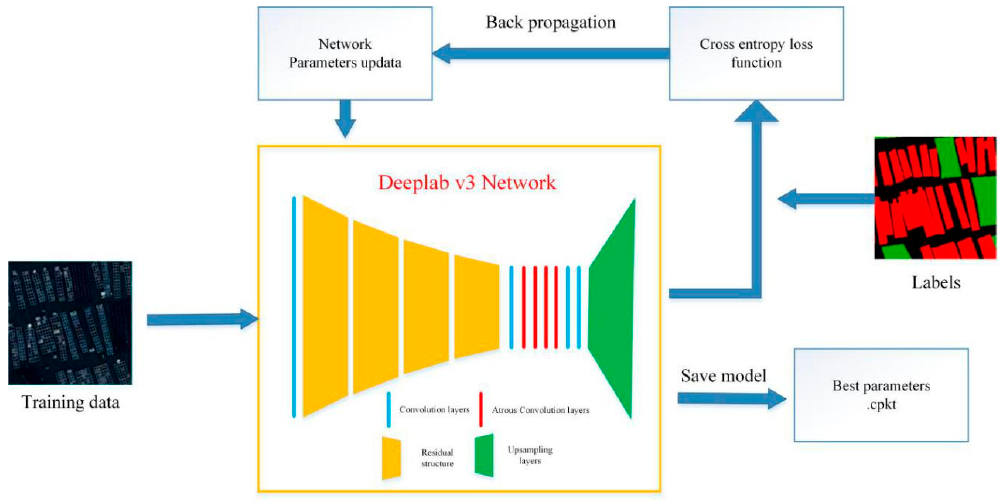
Figure 8. The training flow chart of OAE-V3 model.